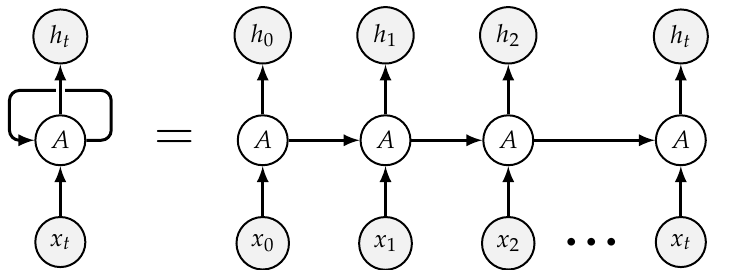
Figure 6. Recurrent neural structure.